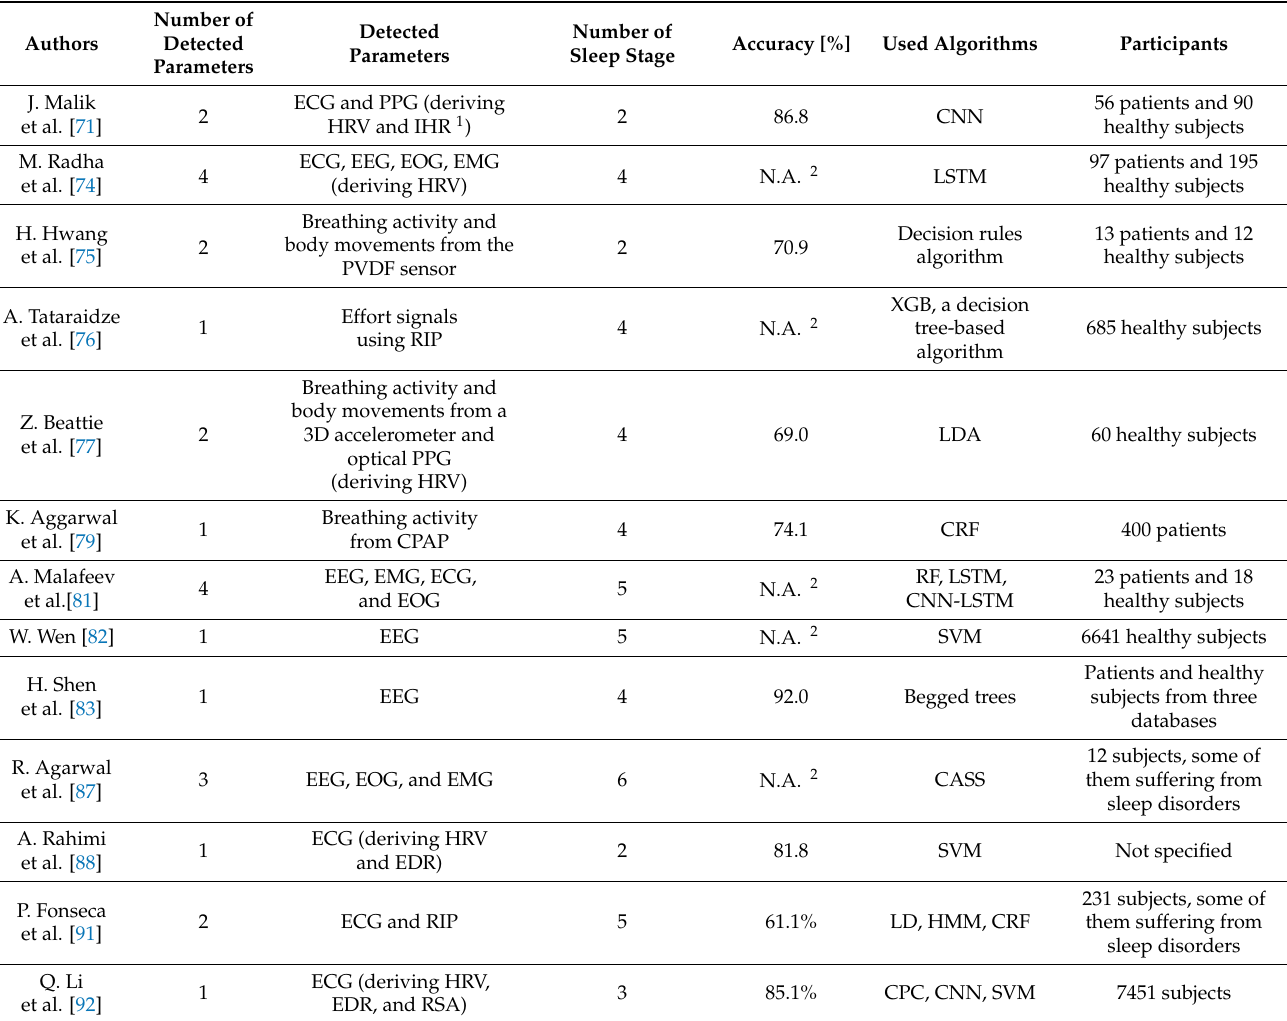
Table 5. Summarizing table of the algorithms for sleep staging discussed above from the points of view of number and typology of detected parameters, employed algorithms, and the number of